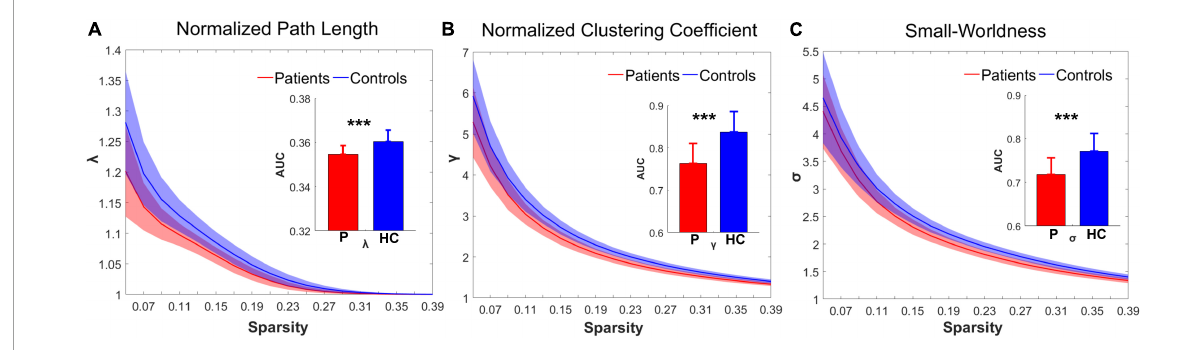
FIGURE1 Group differences in the small-world topological metrics between the IS and control groups. In the range of sparsity (0.05–0.4), the topologies of (A) λ , (B) γ , and (C) σ in both groups exhibited small-world property. Bar charts plot the significant differences of the AUC of λ , γ , and σ between the IS children and controls ( p < 0.05, FDR corrected). ***Significant difference between the two groups. P, patient group; HC, healthy control